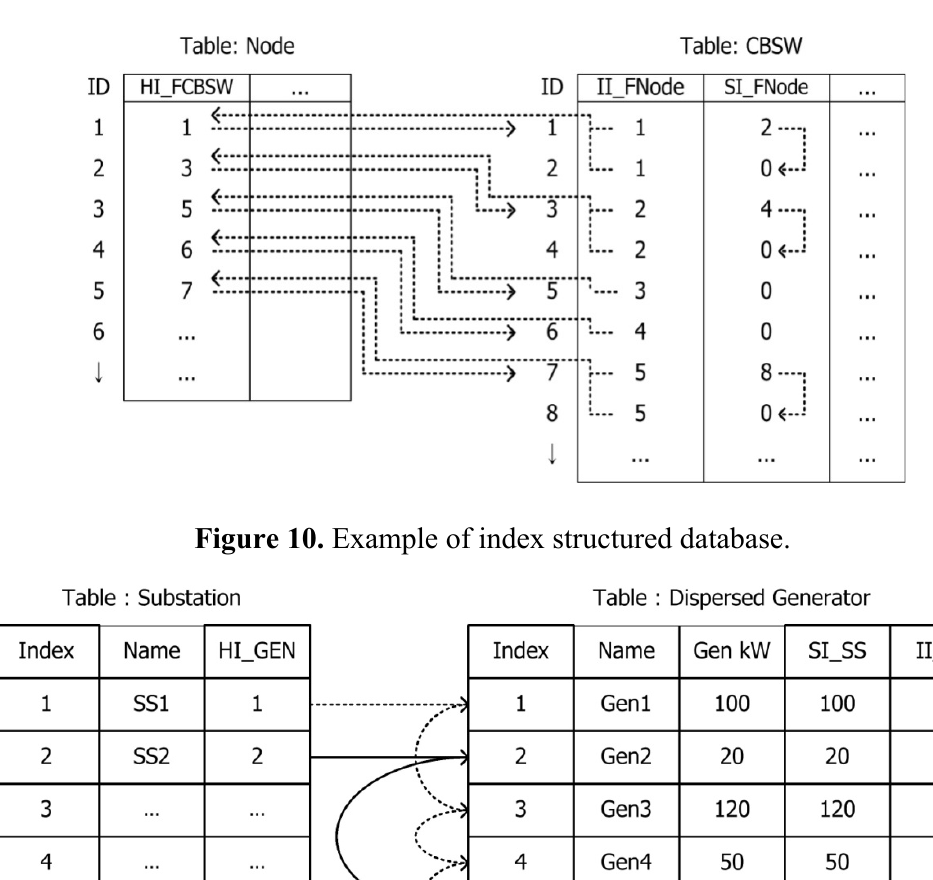
Figure 9. Example of relationship between tables using linked list.